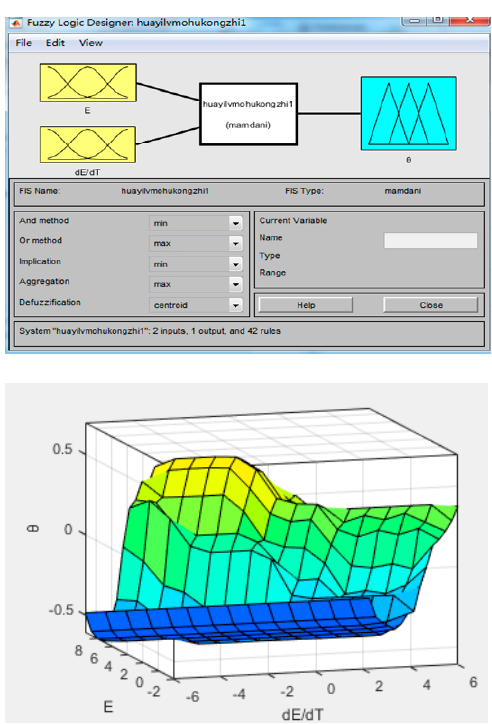
Figure 8. Road surface recognition control output surface.